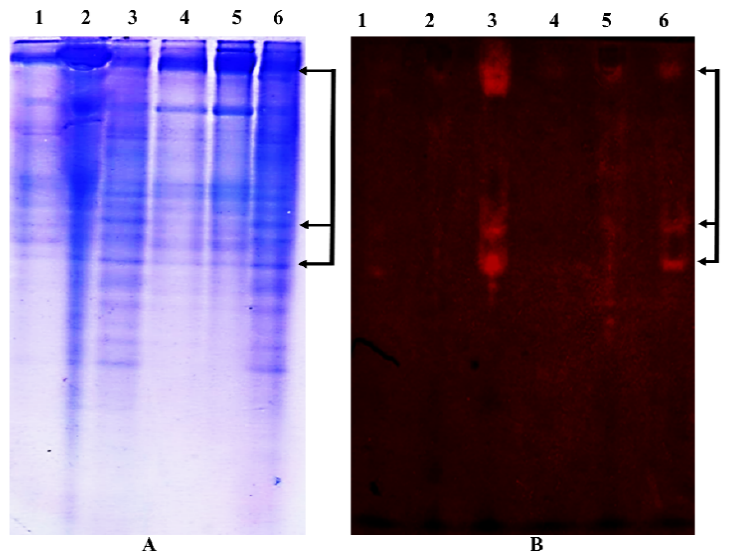
Figure 1. Native gel electrophoresis: ( A ) native-PAGE of canola meal crude extracts after staining with Coomassie brilliant blue and ( B ) corresponding native-PAGE gel showing trypsin inhibitor activity (enzymatic staining). Protein bands with PI activity are indicated by arrows. Lanes: 1, 2, and 3 show 25%, 50%, and 80% saturated ammonium sulphate precipitated (AS) fractions from BLN-3347, respectively; while lanes: 4, 5, and 6 show 25%, 50%, and 80% (w/v) AS fraction from Rivette, respectively.